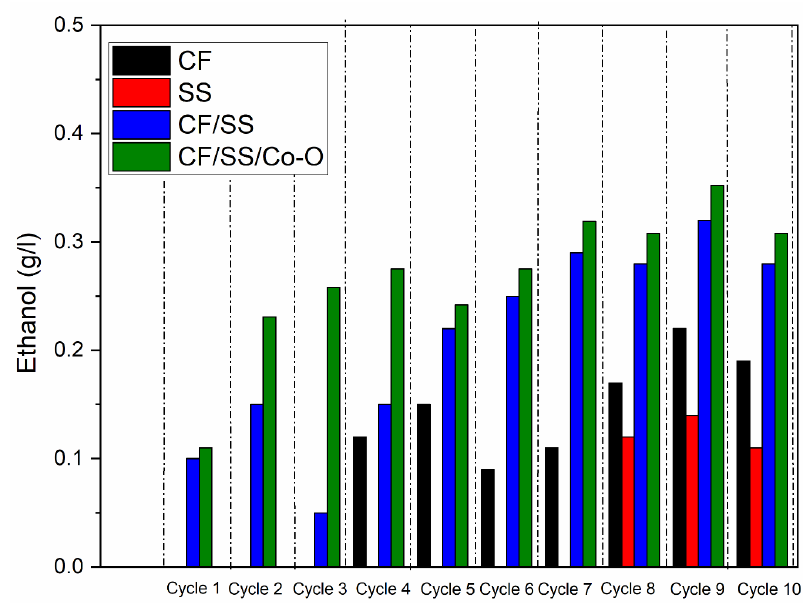
Figure 4. Ethanol in MES operated with varied biocathodes. Table 2. Comparative efficiency of four different based biocathodes MES configured.